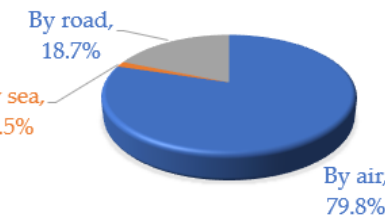
Figure 3. International tourists by region. Source: VNAT (2019).